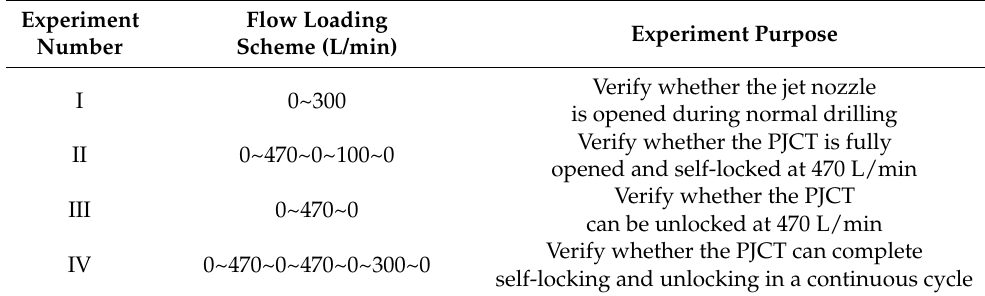
Figure 13. Schematic diagram of experimental principle. Figure 13. schematic diagram of experimental principle. Table 2. Four groups flow loading Table 2. Four groups flow loading schemes.